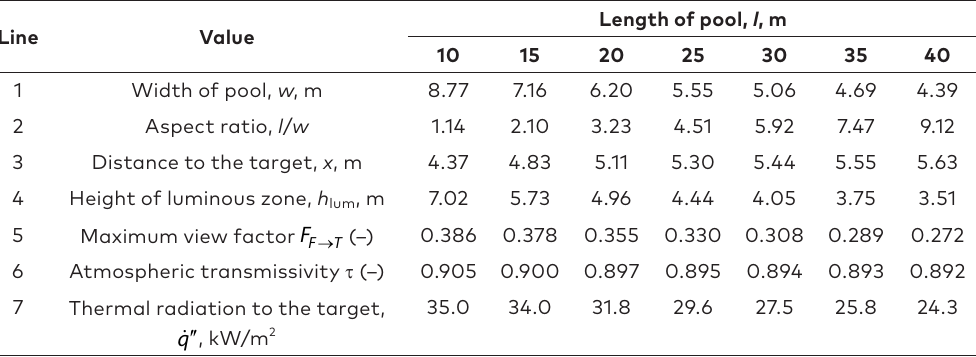
Table 1. Results of the Estimation of the Thermal Radiation  ′′ q at Different Values of the Pool Length